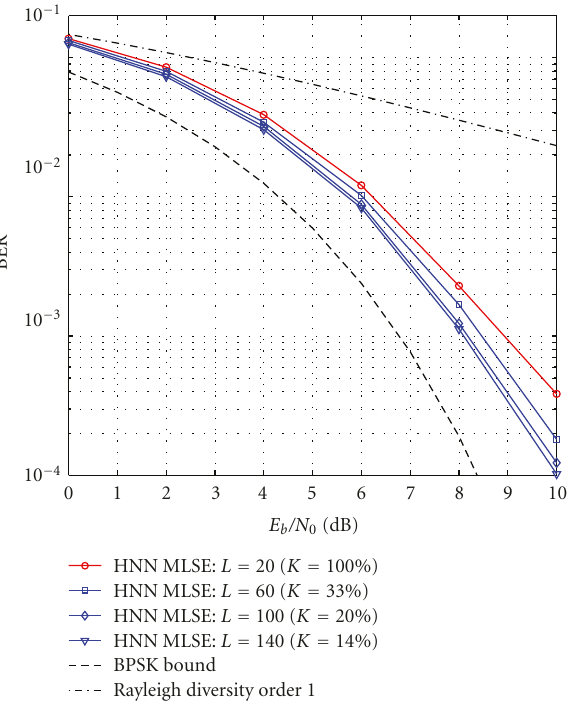
Figure 17: BPSK HNN MLSE equalizer performance in sparse channels.